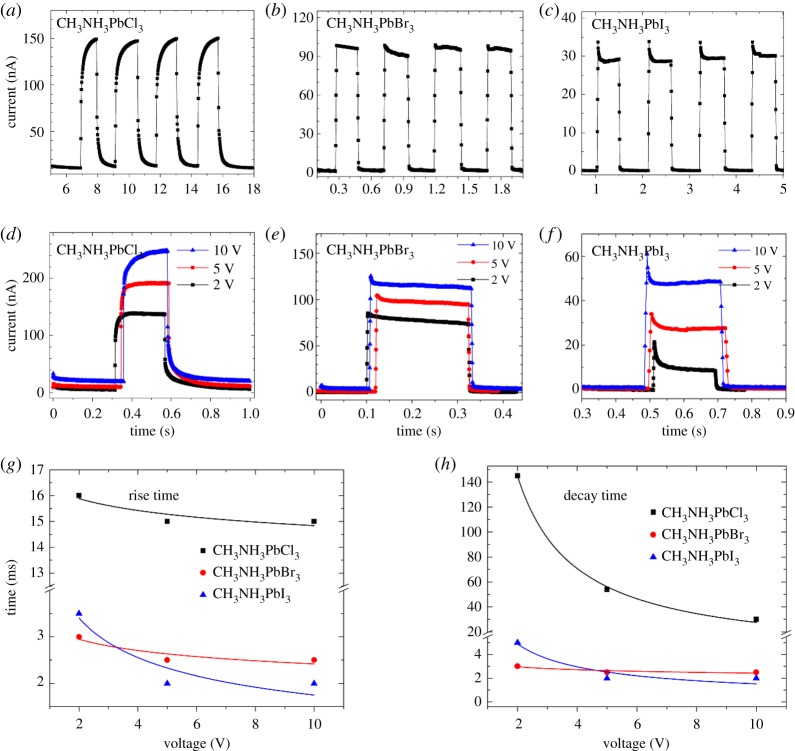
Photo-switching characteristics of (a,d) CH3NH3PbCl3 (b,e) CH3NH3PbBr3 and (c,f) CH3NH3PbI3 photodetectors illuminated under modulated 255 nm light. The rise time (g) and decay time (h) of CH3NH3PbX3 detectors with varying voltage.